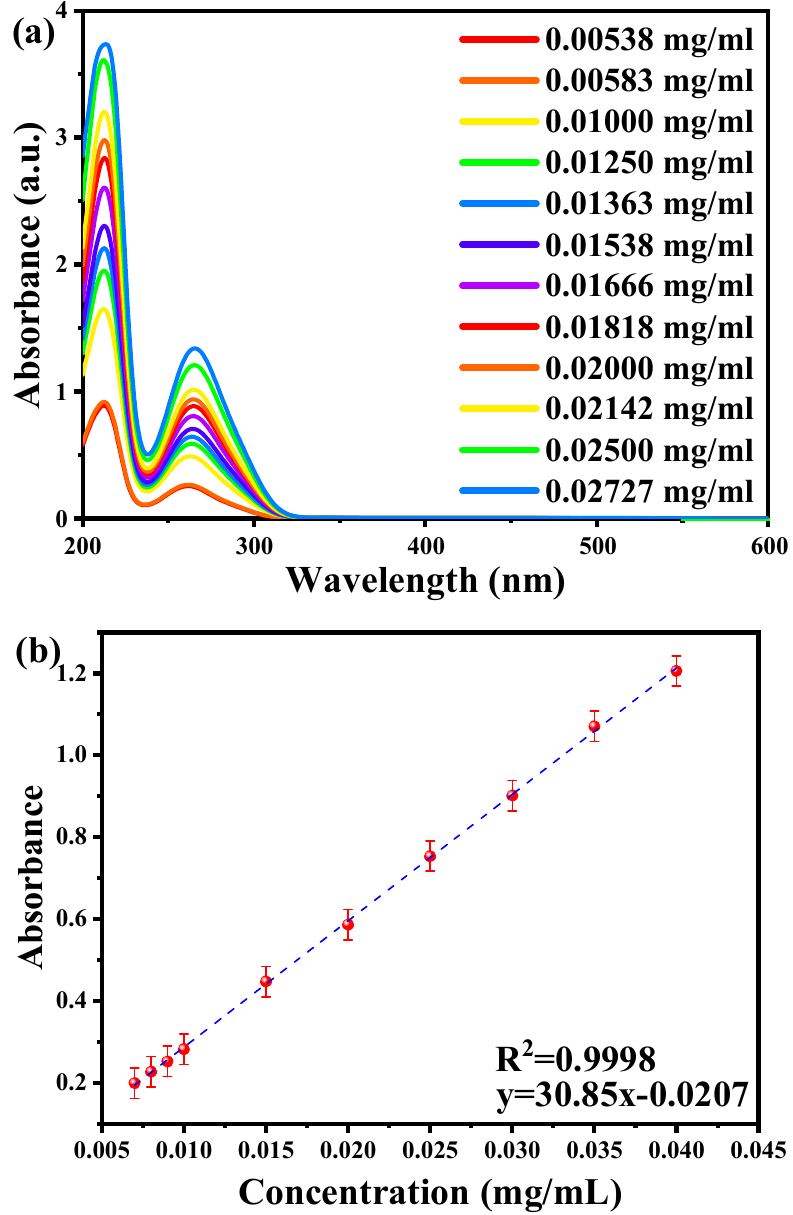
Figure 2. UV-Vis spectrophotometric analysis of GA: ( a ) UV-absorbance curve at different concentrations from 0.00538 to 0.02727 mg/mL; ( b ) Standard solutions calibration curve. Then the samples are read in the UV-vis device from the range 200–500 of the gallic acid where a large matrix is obtained that links the concentrations and absorption for each sample separately. Figure 2a shows the calibration curve of the absorbance (200–900) versus the concertation of the GA, with a correction factor (R 2 = 0.9998) (Figure 2b). Eventually, the resulting UV-Vis spectrometric data were entered into the ODMT, to be considered as the database to predict the concentration of unknown TPC in different plants.